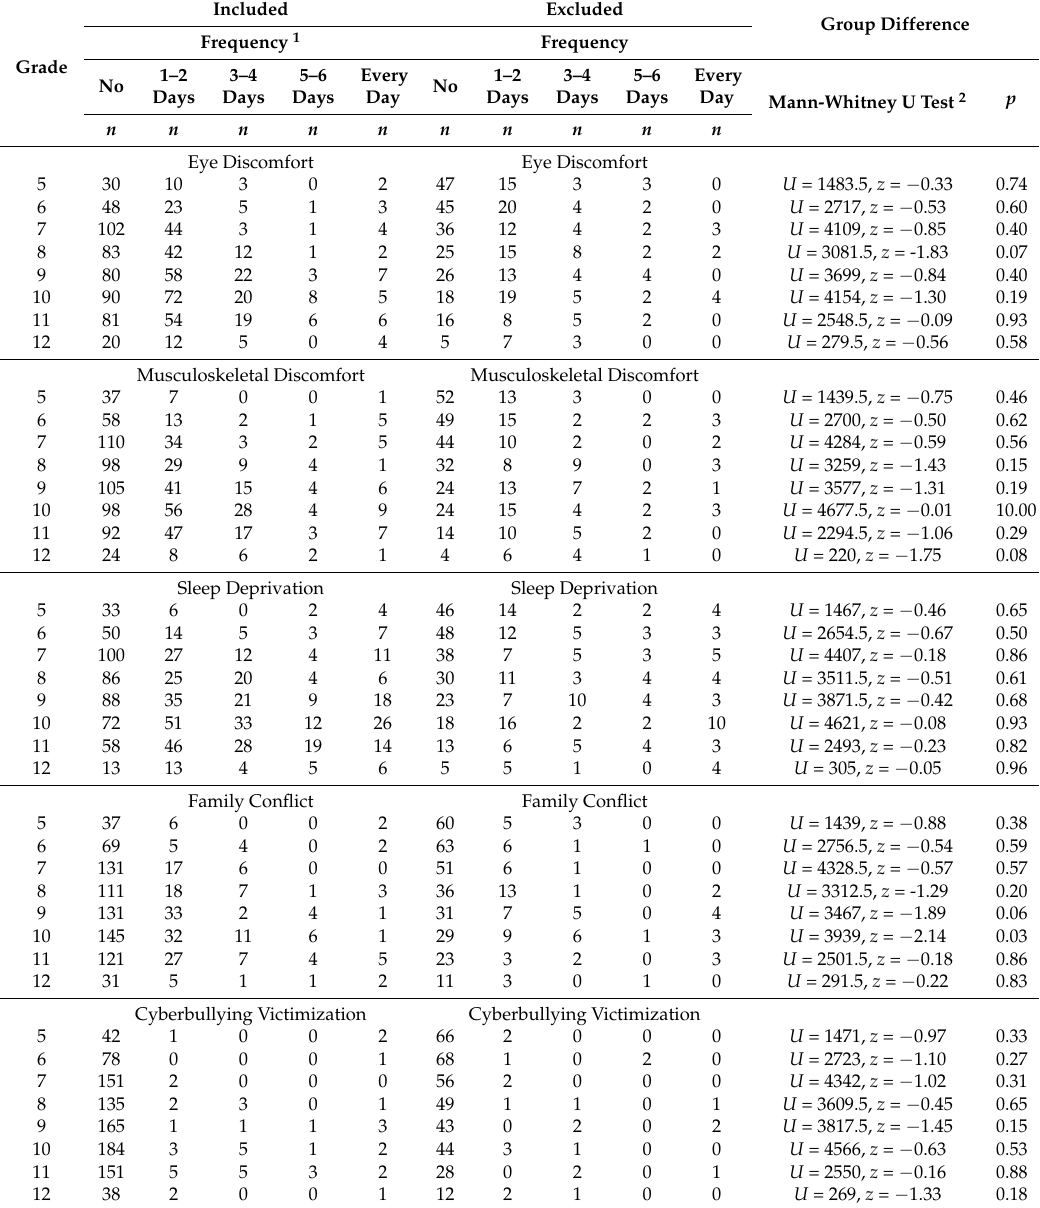
Table A6. Differences in frequencies of physical and psychosocial outcomes related to smart device use in a week between included and excluded respondents by